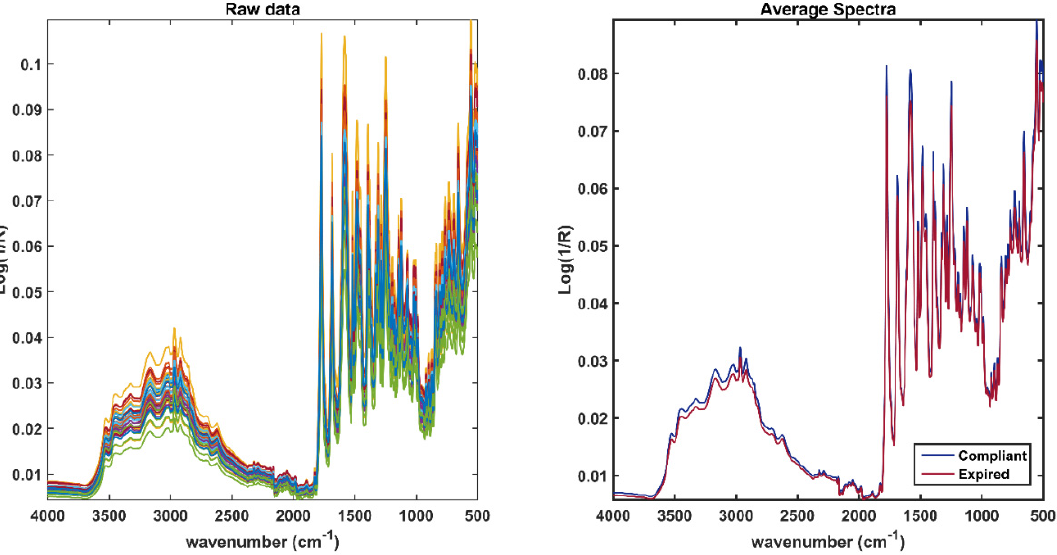
Figure 5. Raw spectra collected on the ground tablet ( left plot); average spectra of expired (red) and compliant tablets ( right plot).